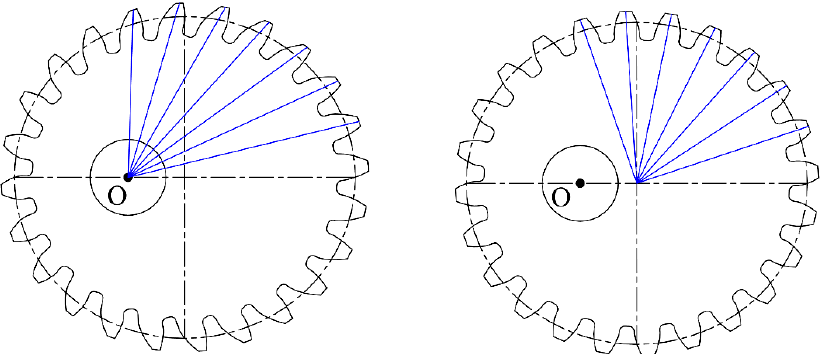
Figure 12. Principal difference between the shape of teeth due to the differential creation of the involute.